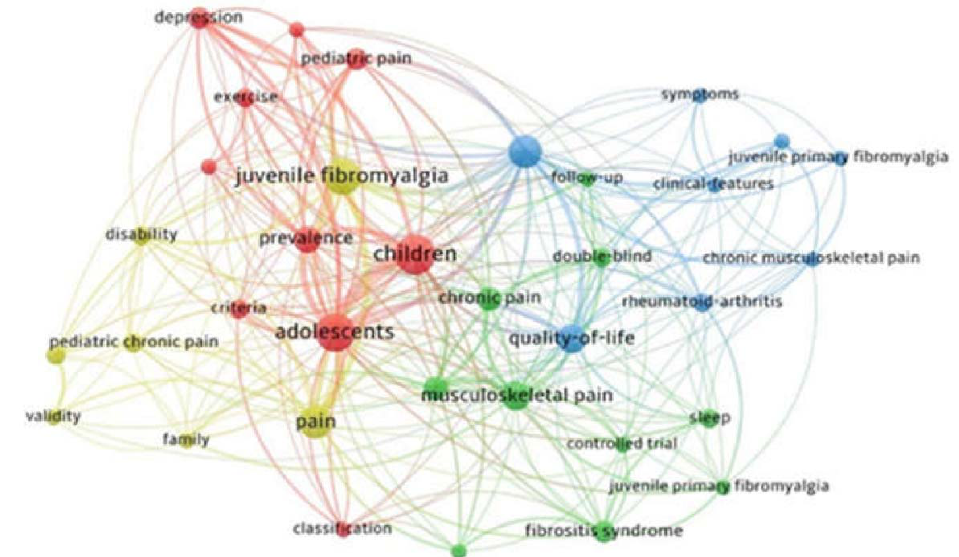
Figure 4. Co-occurrence of keywords. The size of nodes illustrates the frequency of occurrence. The curves between the nodes indicate their co-occurrence in the same publication. The shorter the distance between two nodes, the larger the number of co-occurrences of the two keywords. The analysis yielded 240 keywords; of those, 35 satisfied the threshold (3 times), and finally, 4 clusters were obtained (different colors).